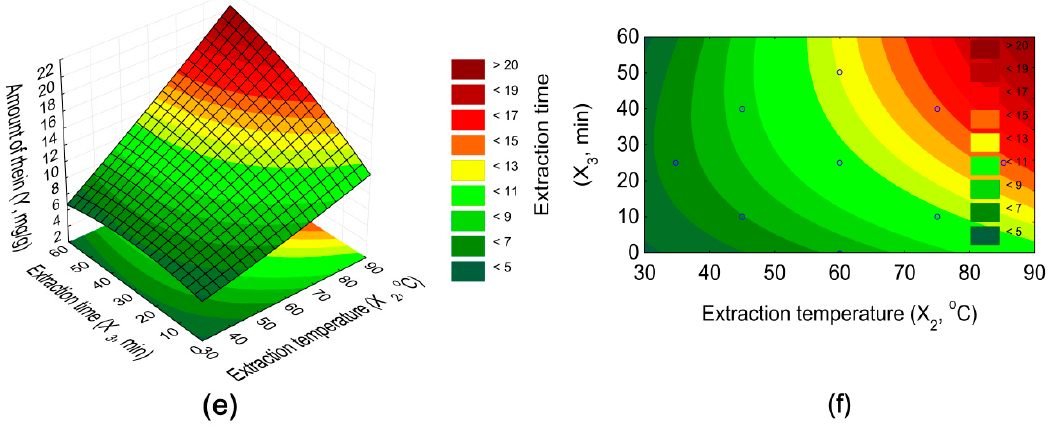
Figure 6. 3D response surface and contour plots: ( a,b ) temperatures and ethanol concentrations, ( c,d ) ethanol concentrations and extraction times, and ( e,f ) temperatures and extraction times on amount of rhein.